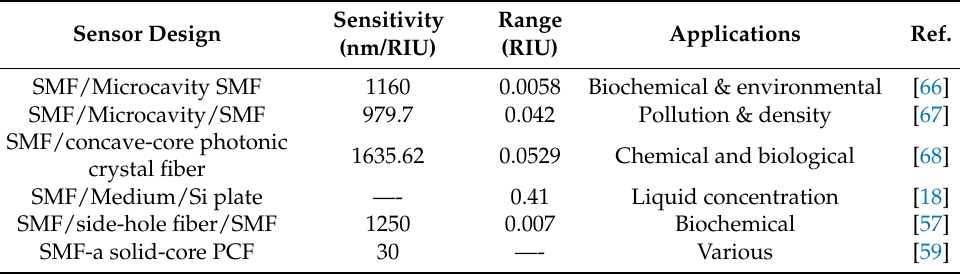
Table 3. Refractive index sensitivity of